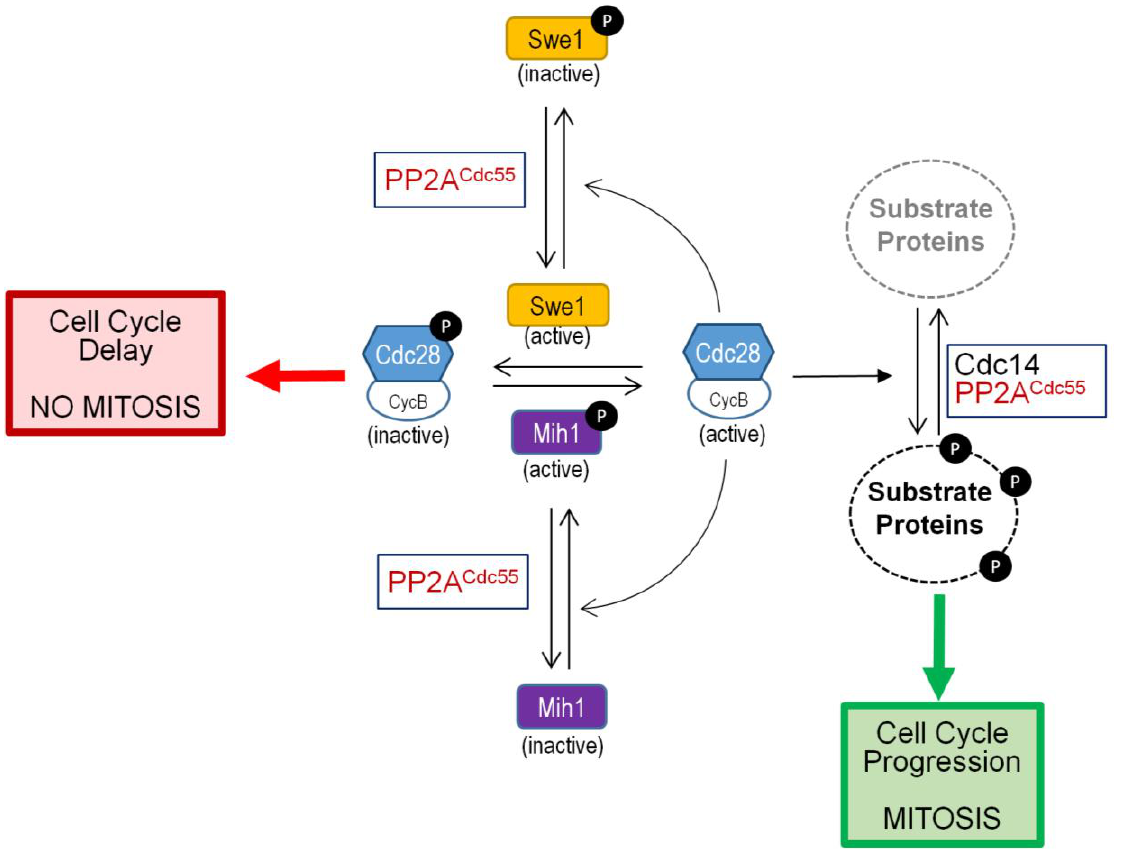
FIGURE 6: Role of PP2A Cdc55 in mitotic entry. The cartoon shows the participation of PP1A Cdc55 associated with Zds proteins (not shown) in the regulation of the phosphorylation state of the S. cerevisiae cyclin-dependent kinase Cdc28. See main text for 227 Microbial Cell | MAY 2019 | Vol. 6 No. 5